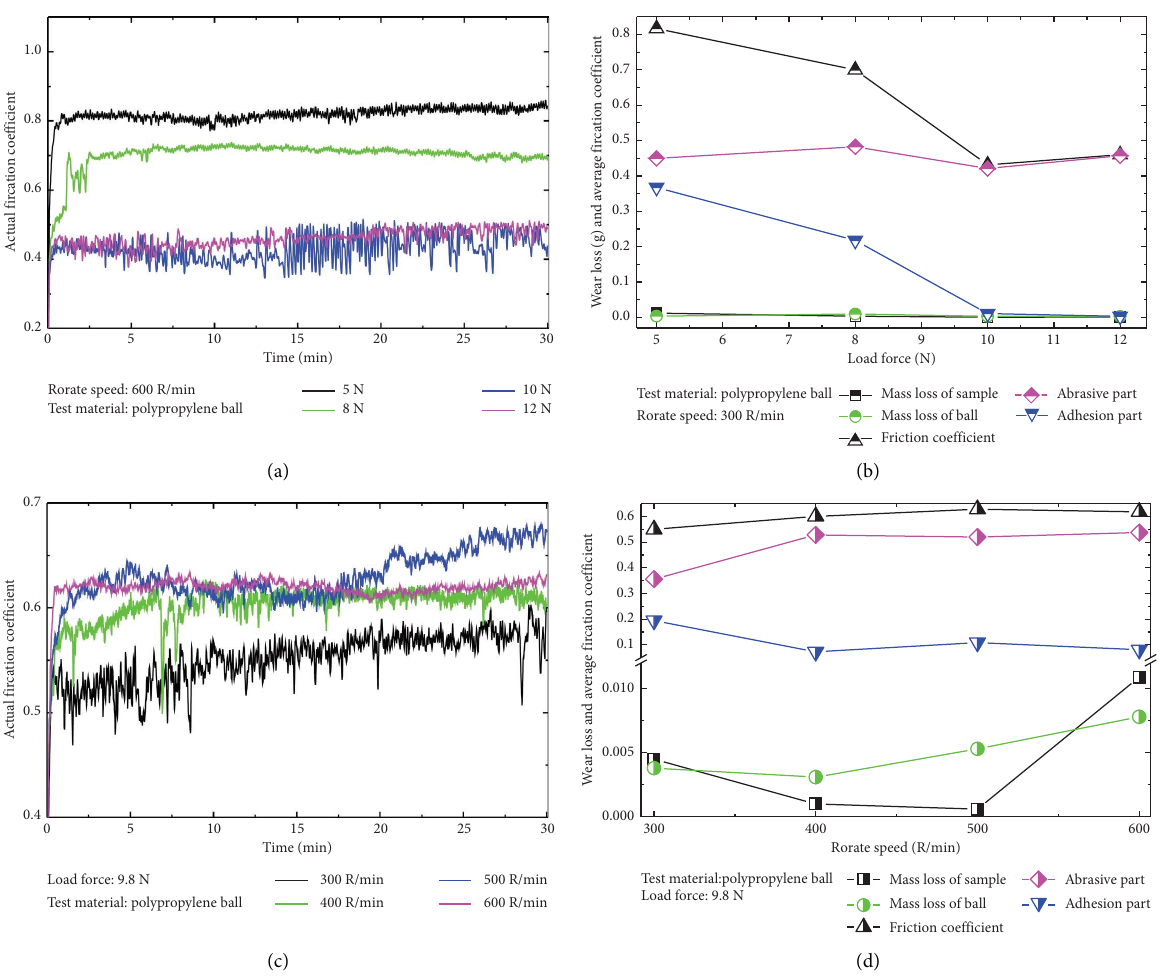
Figure 9: COF (a) and mass loss (b) of the composites with PP pair under 5 − 12N; COF (c) and mass loss (d) of the composites at 300–600rpm/min.